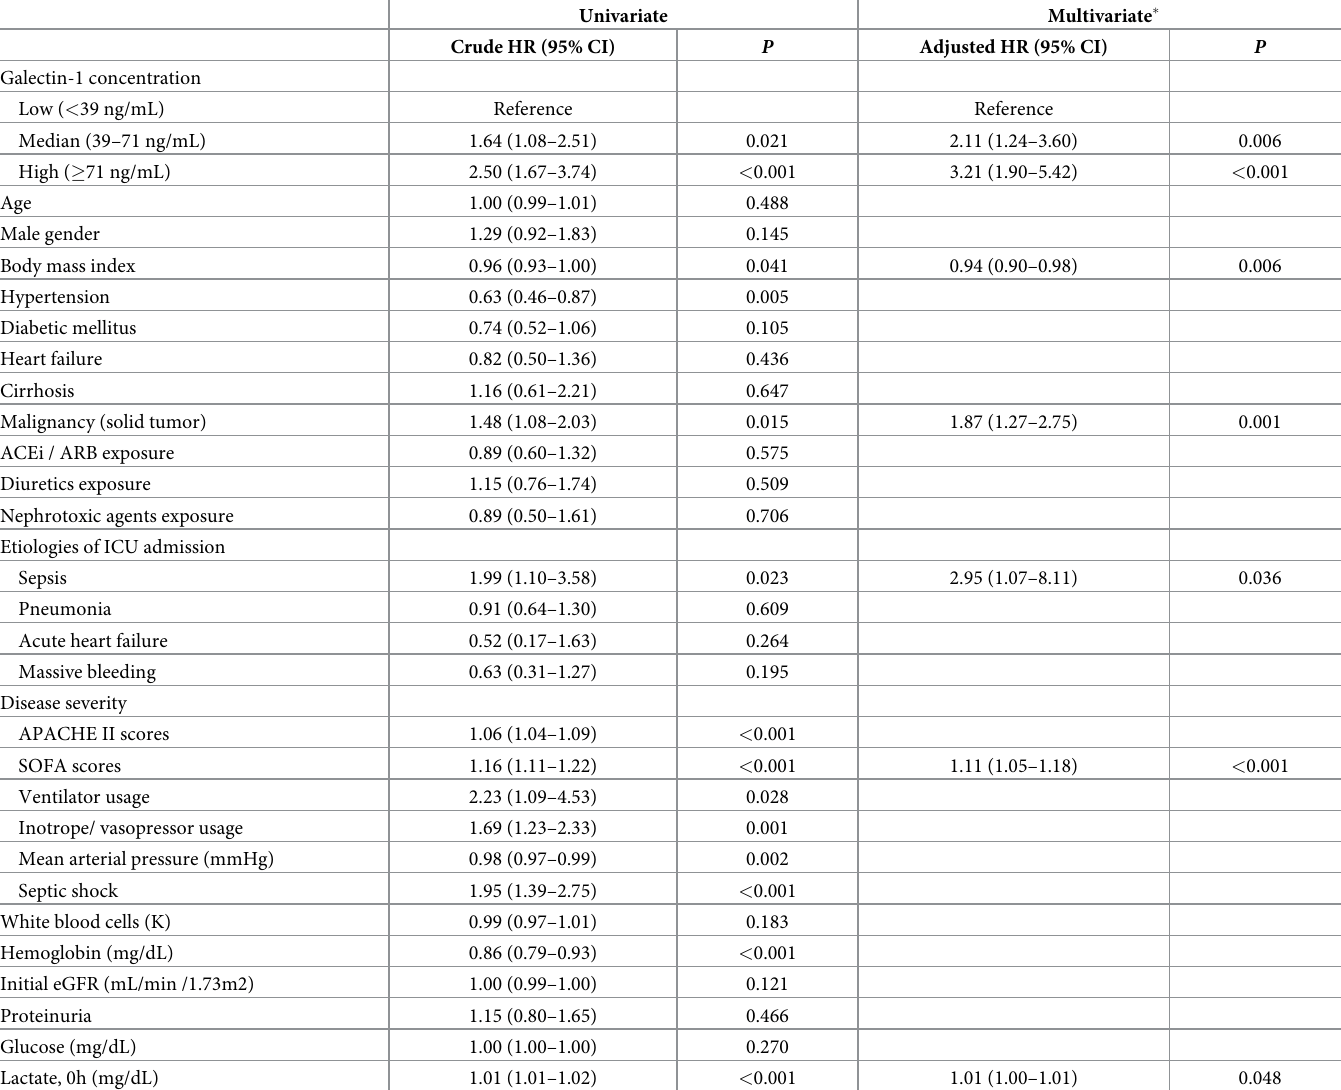
Table 3. Multivariate associations of the galectin-1 tertiles and factors with all-cause mortality within 90 days among critically ill patients (forward stepwise multi- variate regression